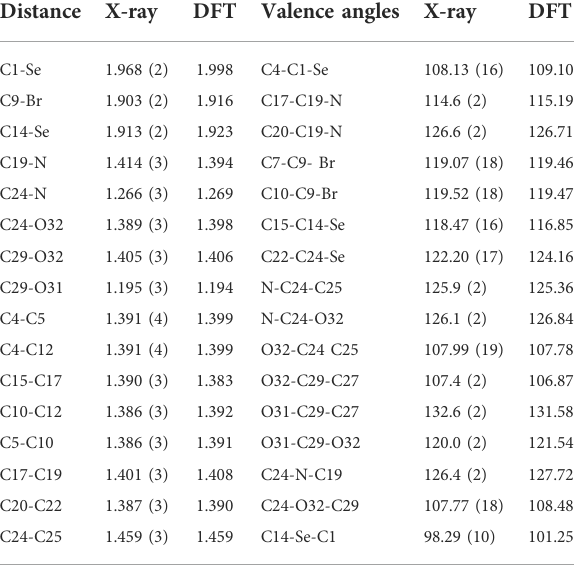
TABLE 5 Geometric parameters obtained using DFT/B3LYP//6-311 ++ G(d,p). Distance X-ray